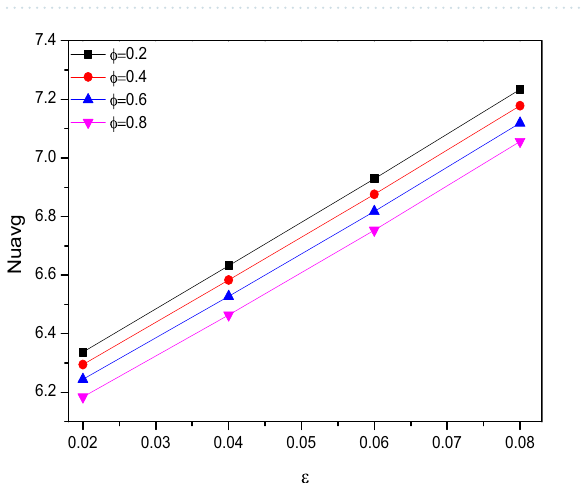
Figure 18. Variations of the streamlines ( (cid:31) ) and isotherms ( T ) with various φ at Ra = 10 6 , Ha = 0 , Da = 0.01 , ω = 0 , N = 4 , r = 0.1 and ε = 0.2 .